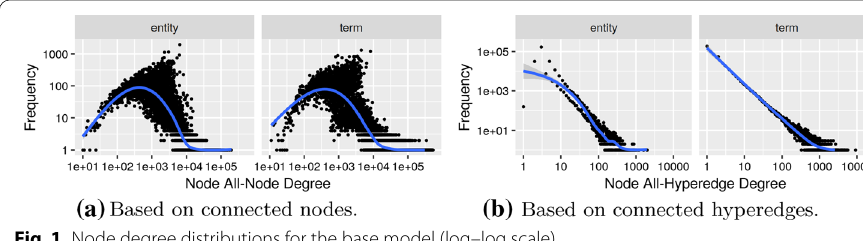
Fig. 1 Node degree distributions for the base model (log–log